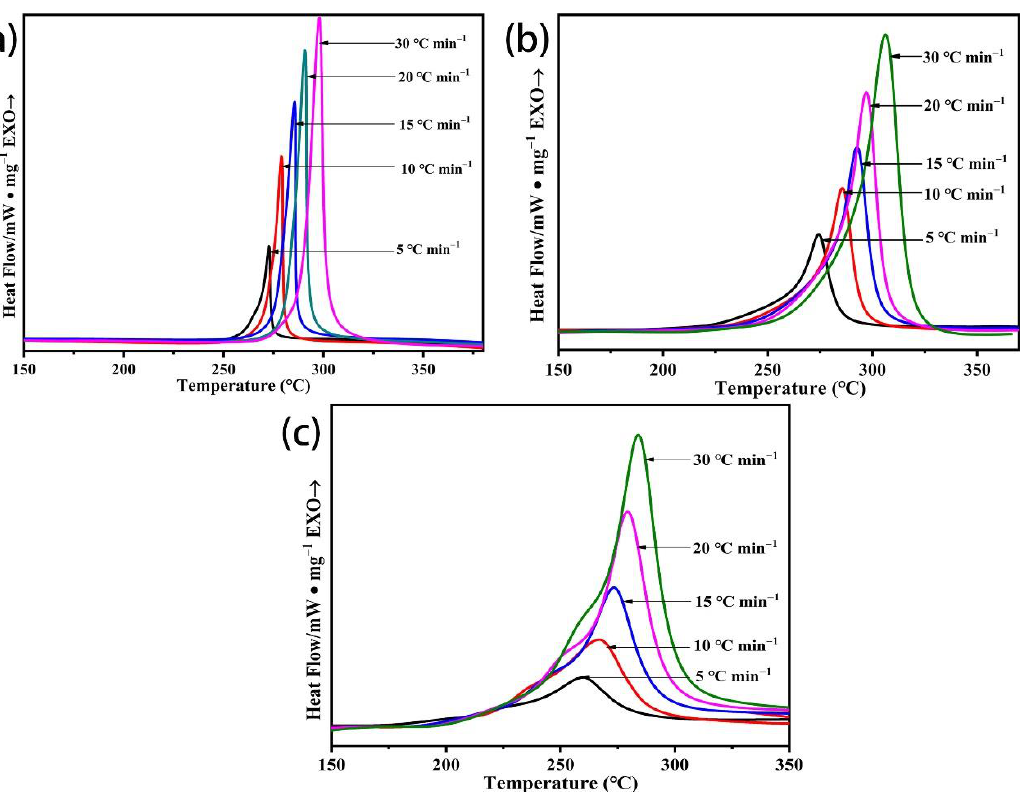
Figure 12. DSC curves of ( a ) PAN, ( b ) P (AN-MA-AA) with mass feed ratio of AN/MA/AA = 98/2/2, and ( c ) P (AN- co - MLA) with AN/MLA feed ratio = 97/3 heated at different rates.